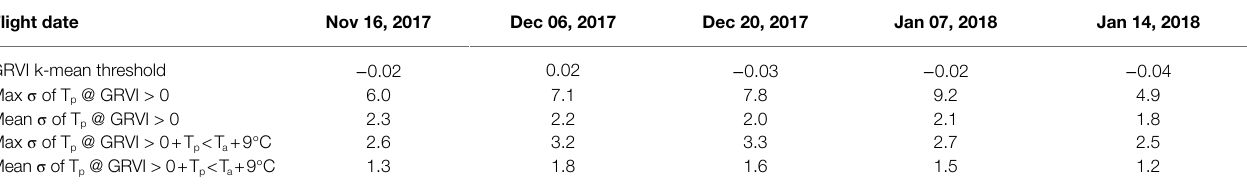
TABLE 2 | The GRVI k-mean thresholds separating vegetation and the soil background across the five UAV data collection dates, as well as standard deviation ( σ ) of plant temperature